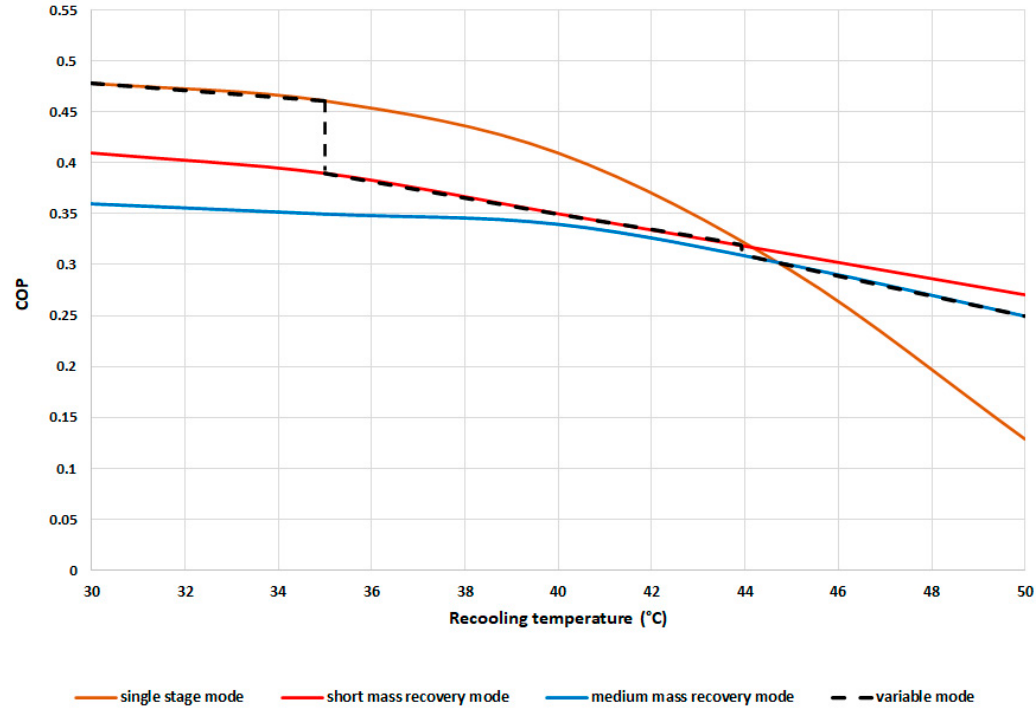
Figure 20. Predicted COP for various modes and recooling water temperatures.